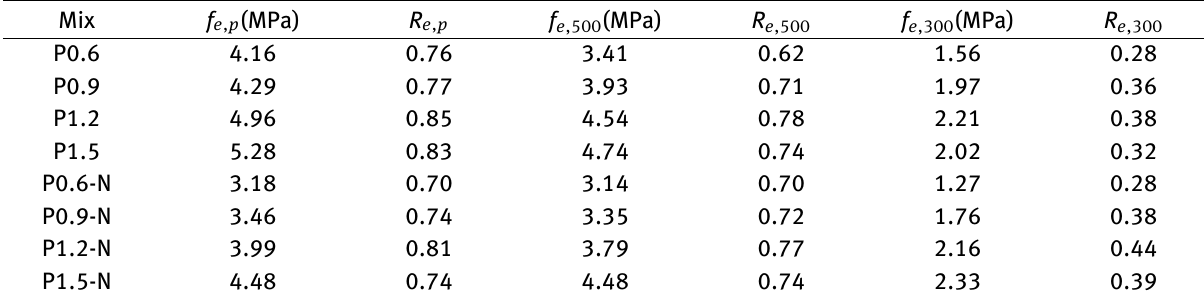
Table 6: Summary of bending